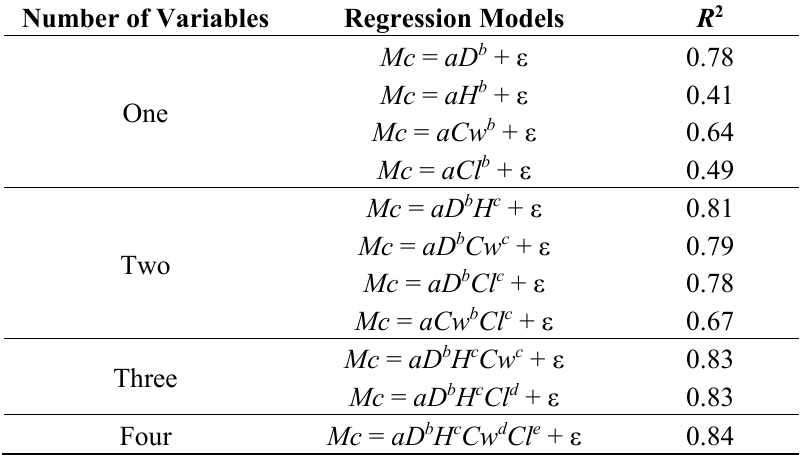
Table 2. Regression relationships between crown biomass and tree